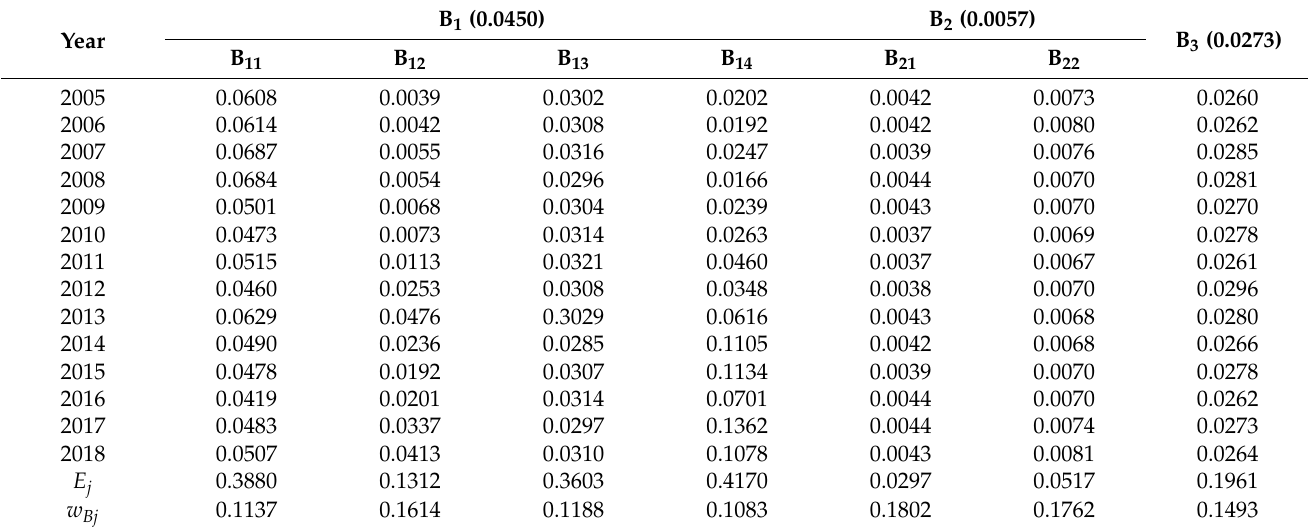
Table 3. Information entropy and weight of each indicator of